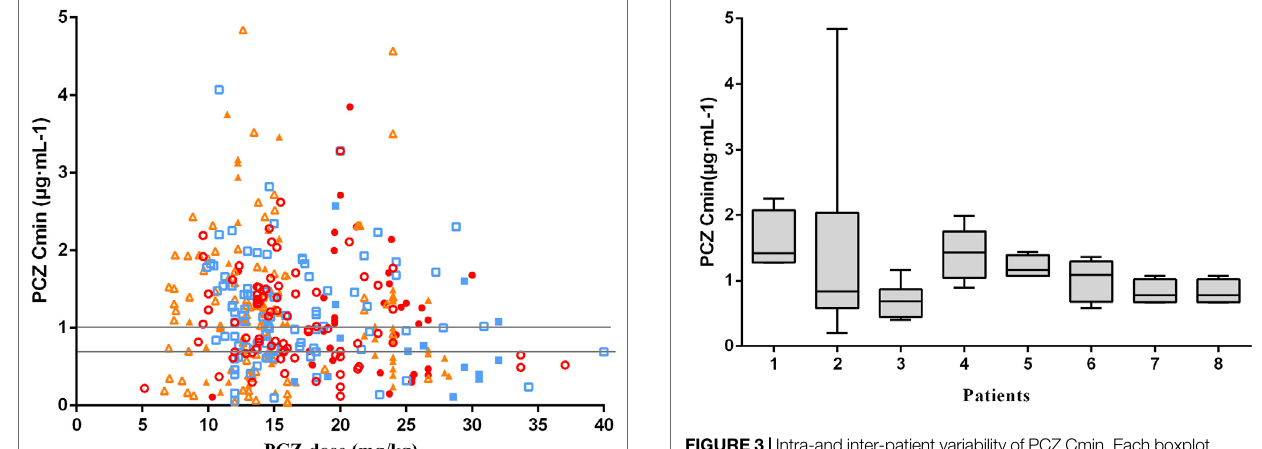
FIGURE 3 | Intra-and inter-patient variability of PCZ Cmin. Each boxplot representsPCZlevels(median,minimum,maximumandinterquartilerange)of a single child for a total of 8 children receiving 12 mg/kg/day of PCZ suspension who had fi ve or more sample